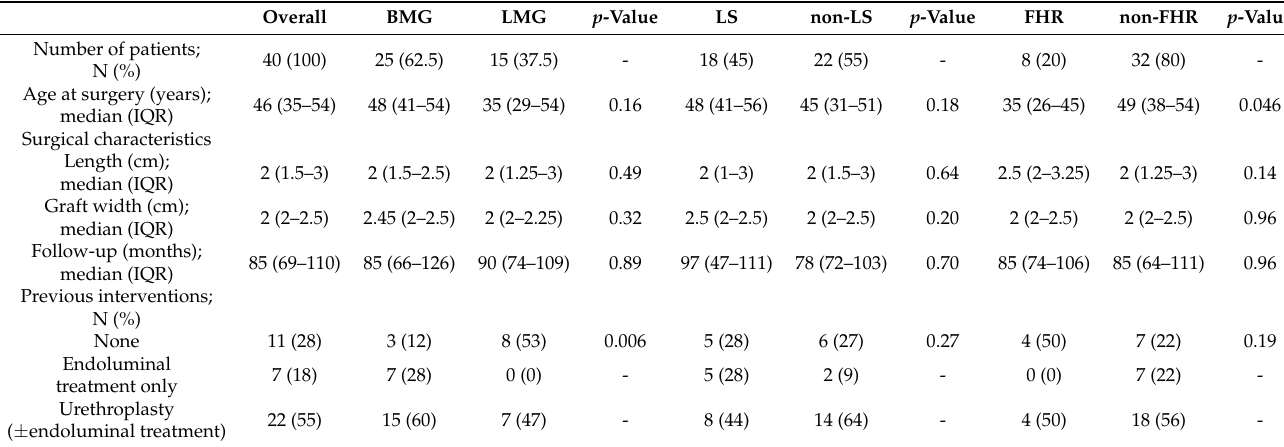
Table 1. Surgical characteristics of 40 patients who underwent single-stage dorsal inlay oral mucosal graft urethroplasty for meatal strictures between 2000 and 2021 stratified by substitute tissue, Lichen Sclerosus and Failed Hypospadias Repair.